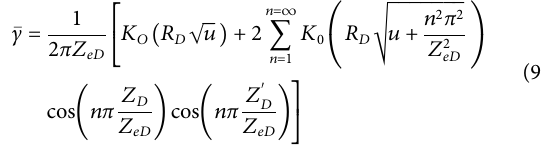
The bottom hole pressure response function calculation model of the horizontal well in the top-bottom reservoir is established, and the in fi nite formation pressure distribution plan is de fi ned, as is shown in Figure 4. The formation pressure of the horizontal well is elliptical in the near well zone and radial in the far well zone. The pressure drop mainly occurs within 50 m from the bottom of the well. The formation pressure of the fractured horizontal well is elliptical in the near well zone and radial in the far well zone, as is shown in Figure 5. The effective displacement pressure system of horizontal well and volume fracturing well is demonstrated by using the formation pressure calculation formula of horizontal well and volume fracturing well, combined with the potential superposition theory.